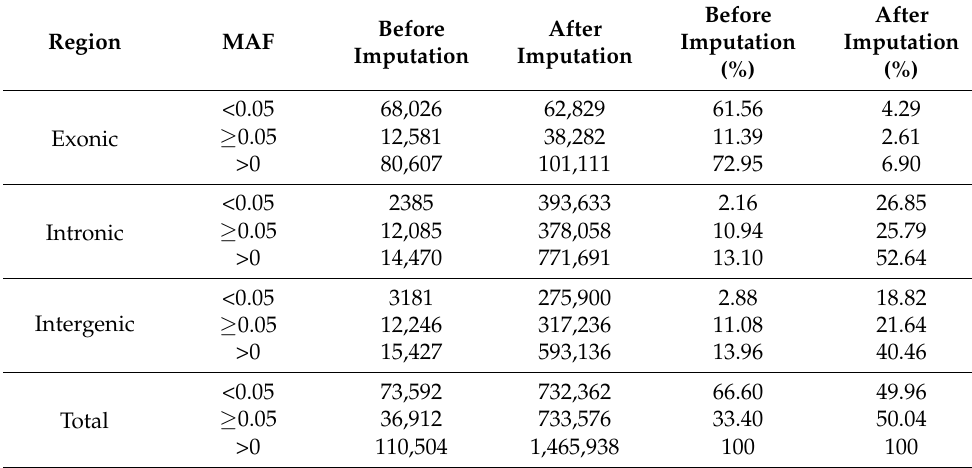
Table 1. Composition of the genotype dataset before and after